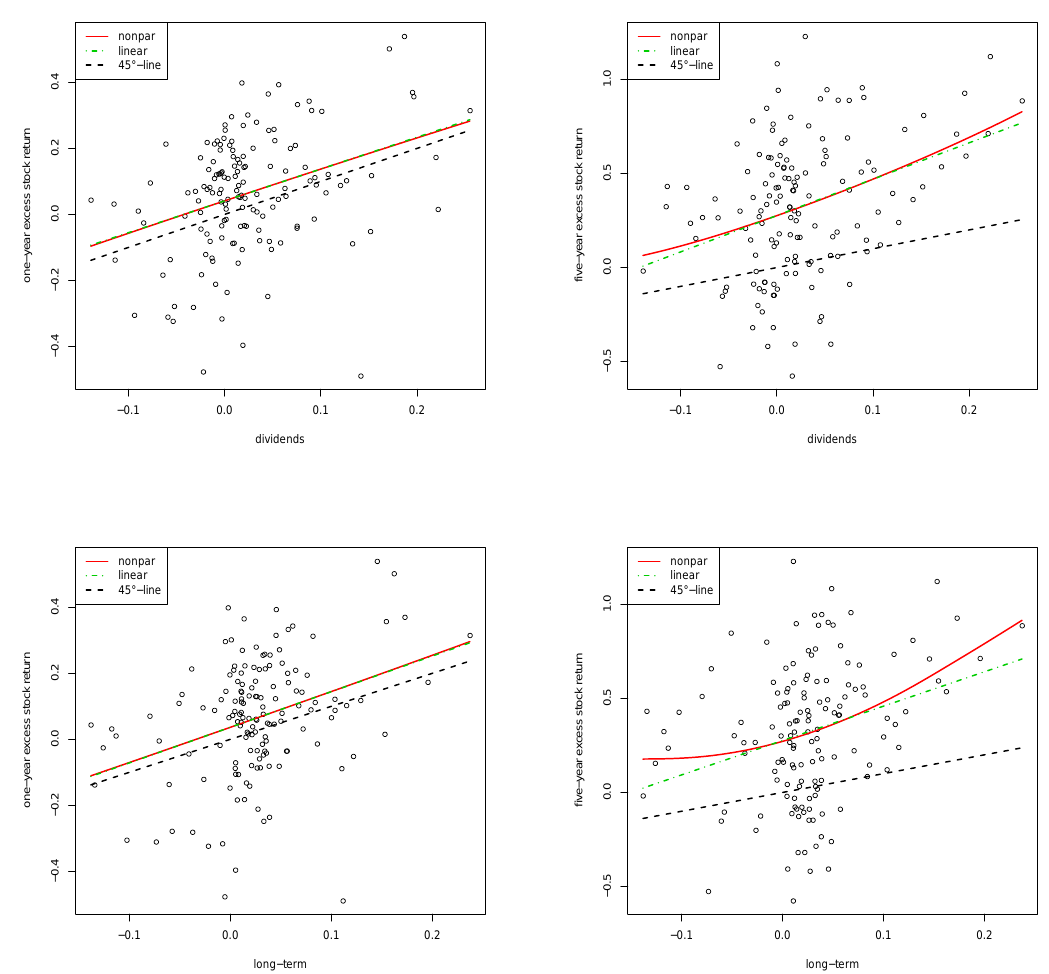
Figure 5. Double inflation benchmark. Relation between real stock returns and real earnings-by-price ( top ), real dividends-by-price ( middle ), and the real long-term interest rate ( bottom ). Estimated nonparametric function ˆ m (red solid line), linear model (dash-dotted green line), and 45-degree line (dashed black line). Left : one-year horizon. Right : five-year horizon. Period: 1872–2019. Data: annual S&P